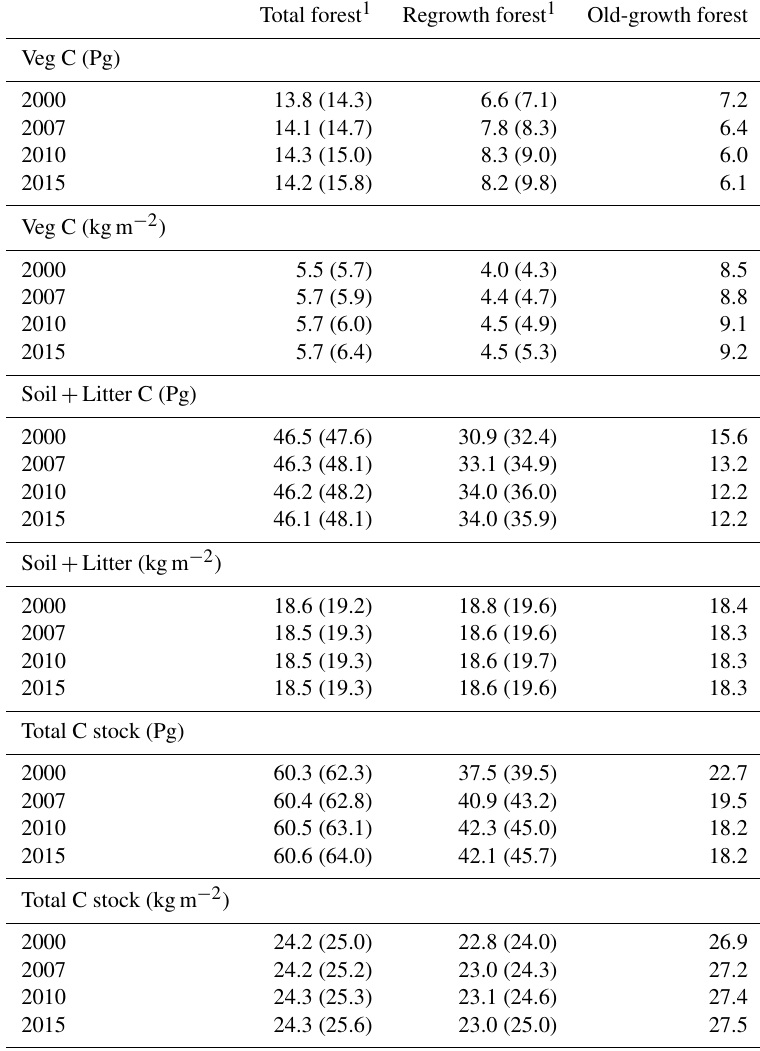
Table 5. Vegetation carbon and total carbon stock in European forests separated into regrowth and old-growth